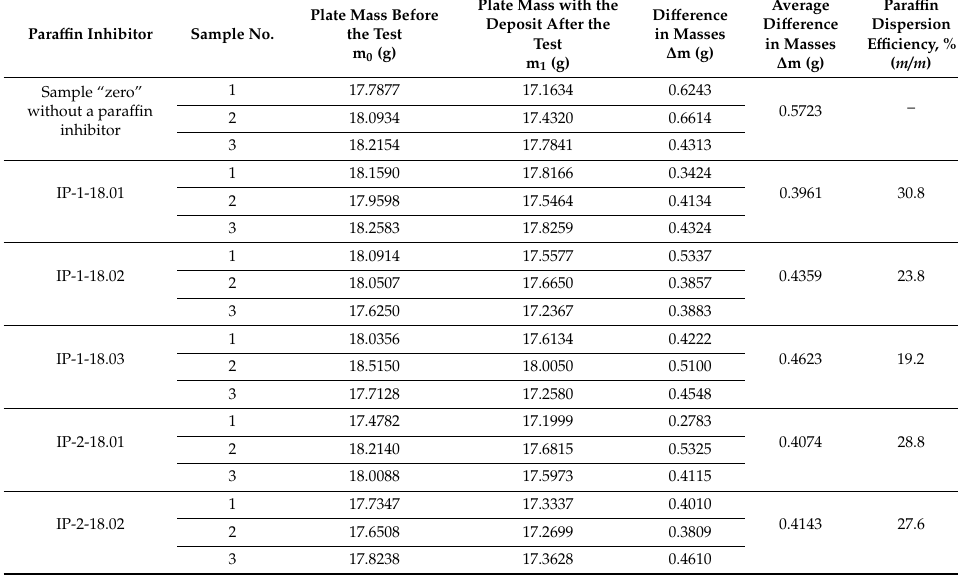
Table 6. Dispersing properties of para ffi n inhibitors IP-1-18.01, IP-1-18.02, IP-1-18.03, IP-2-18.01, IP-2-18.02 selected for the tests with a dosage of 1000 mg / kg, at a temperature of 50 ◦ C. Plate Mass with the Plate Mass Before Deposit After Para ffi n Inhibitor Sample No. the Test m 0 (g)